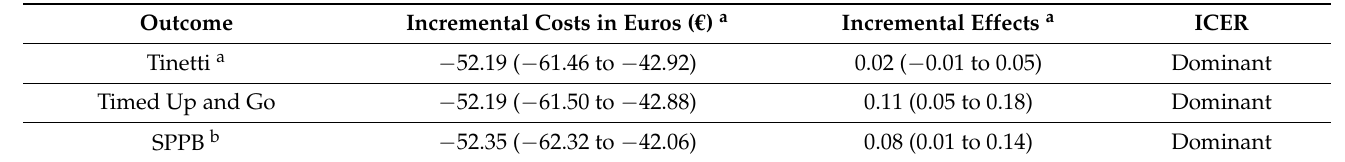
Table 3. Incremental costs and health effects during the 12-month follow up adjusted for age, sex, education level, study site, SPPB, and Tinetti results at baseline ( p -value <